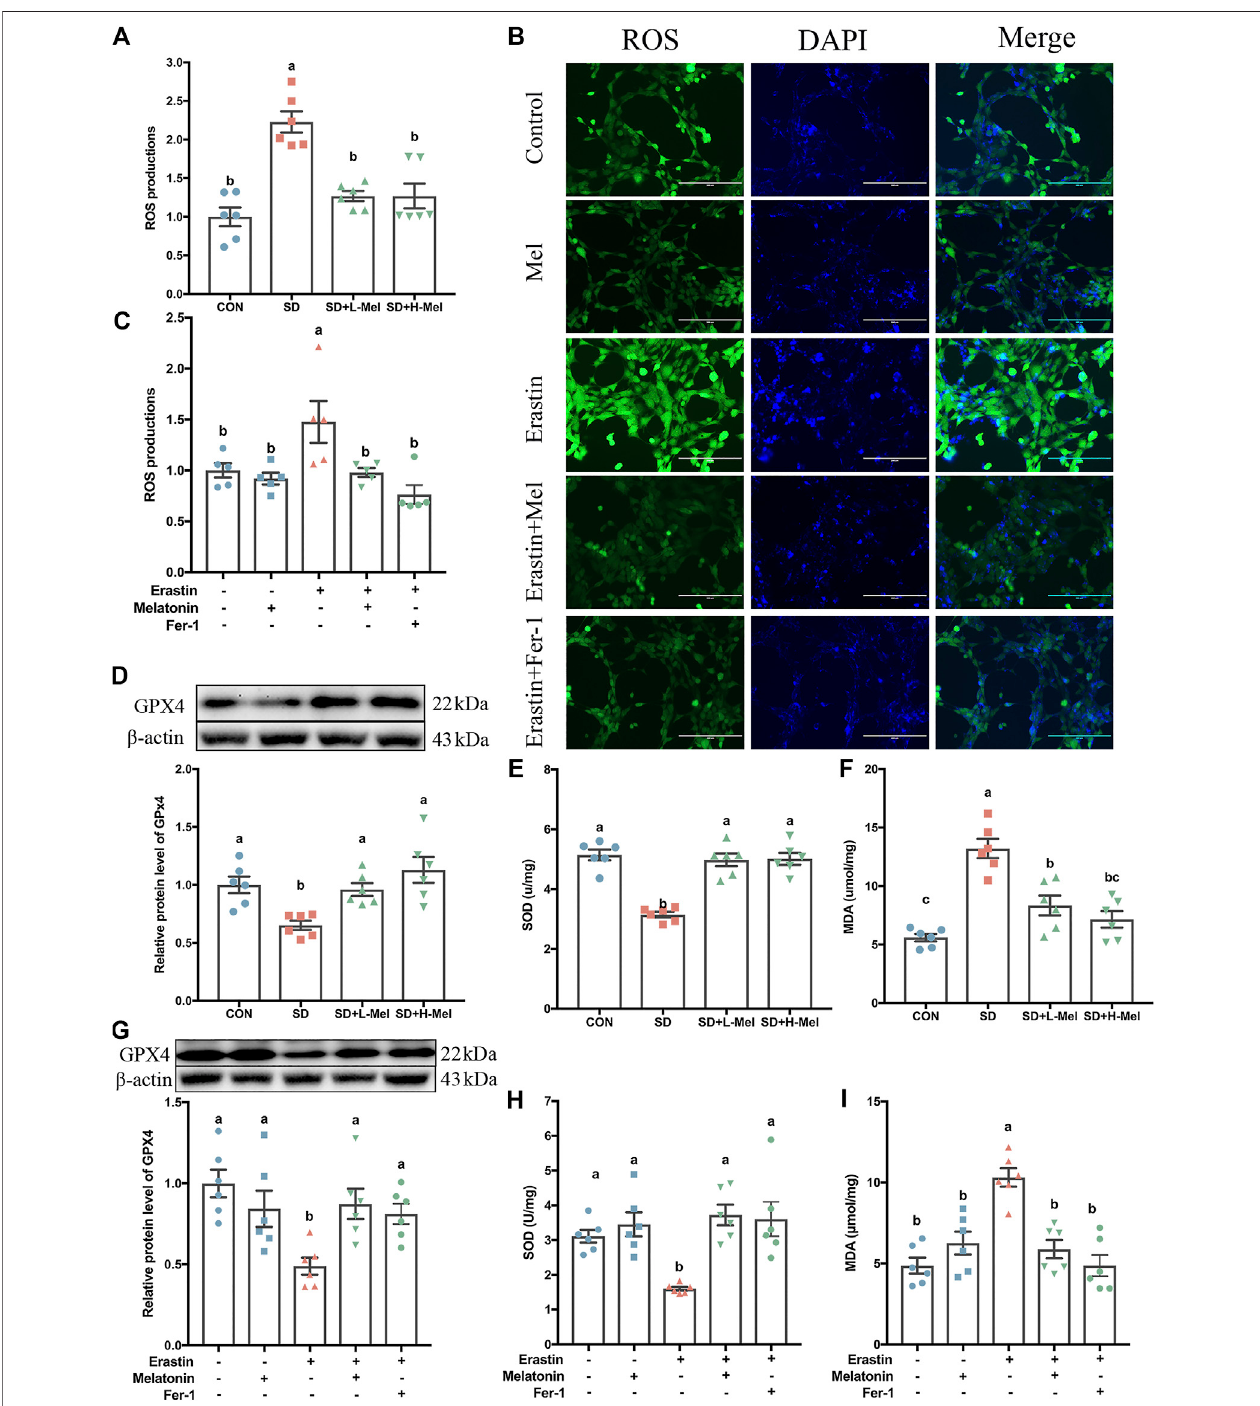
FIGURE 4 | Effect of melatonin on antioxidative activation and lipid peroxidation in the hippocampus of sleep-deprived mice. (A) Relative quanti fi cation of the ROS assay in the hippocampus tissue ( n (cid:1) 6). (B) Fluorescence staining of ROS in HT-22 cells exposed to Erastin and melatonin or Fer-1. Green represents ROS, while blue represents DAPI. Bar (cid:1) 200 μ m. (C) Relative quanti fi cation of intracellular ROS level in the HT-22 cells exposed to Erastin and melatonin or Fer-1 (n (cid:1) 5). (D – F) Relative levels of GPX4, SOD and MDA in the hippocampus ( n (cid:1) 6). (G-I) Relative levels of GPX4, SOD, and MDA in HT-22 cells exposed to Erastin and melatonin or Fer-1 ( n (cid:1) 6). Differences were assessed by one-way ANOVA. The result represents the mean ± standard error of the mean. Values not sharing a common superscript letter differ signi fi cantly at p < 0.05; those with the same letter do not differ signi fi cantly ( p ≥ 0.05). CON: control group, SD: sleep deprivation group, SD + L-Mel: SD + low melatonin (20 mg/kg) supplement group, SD + H-Mel: SD + high melatonin (40 mg/kg) supplement group.